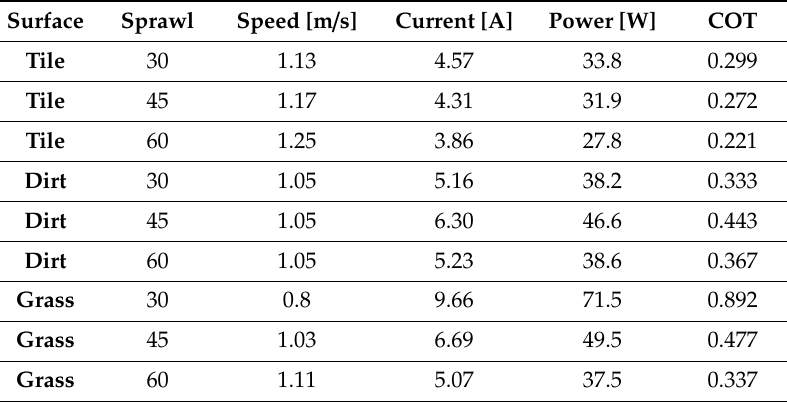
Table 2. The power requirements of BSTAR.